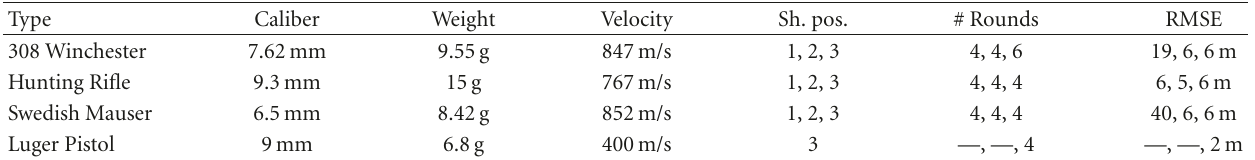
Table 3: Armament and ammunition used at the trial, and number of rounds fired at each shooter position. Also, the resulting localization RMSE for the MB-SW model for each shooter position. For the Luger Pistol the MB model RMSE is given, since only one microphone is located in the Luger Pistol SW cone.